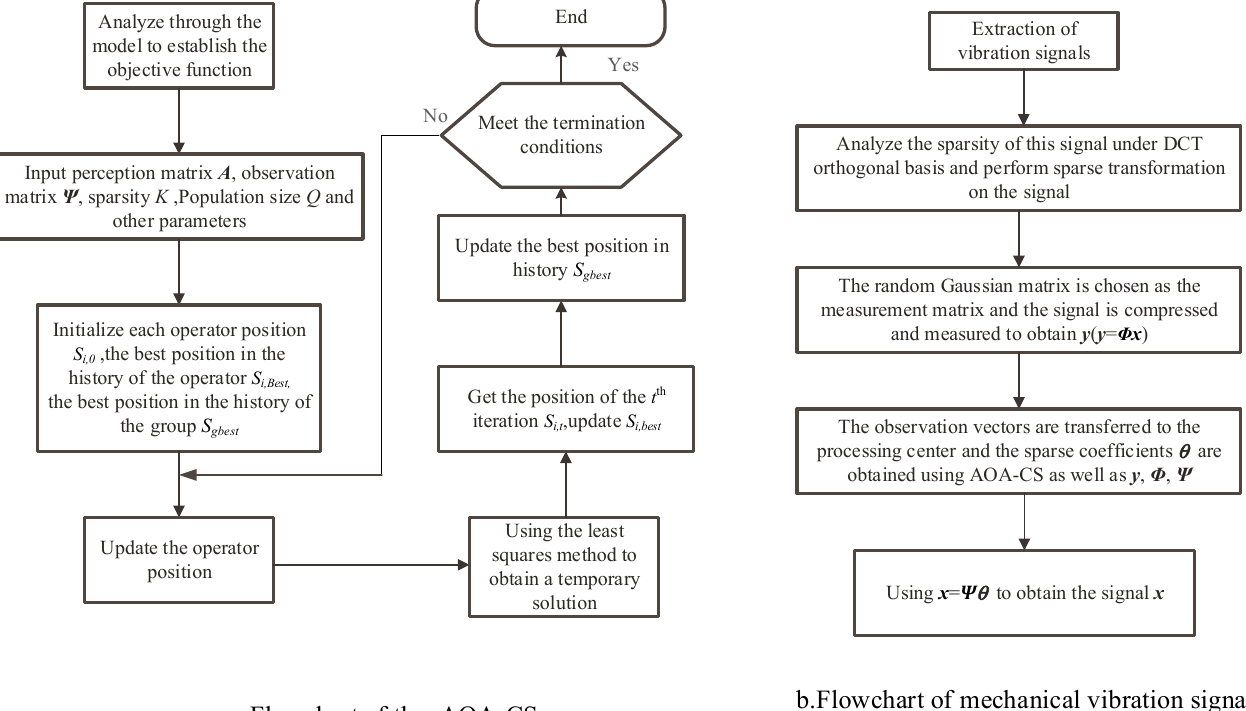
Figure 2. Flowchart of optimization algorithm and reconstructed signal.